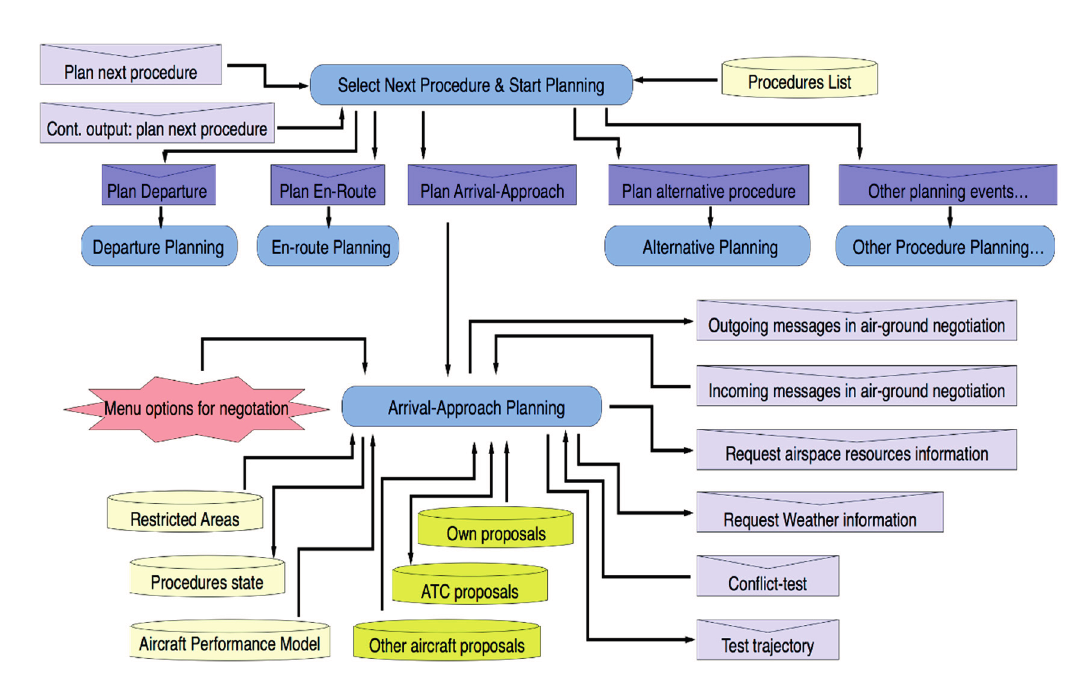
Figure 8. Next procedure planning capability